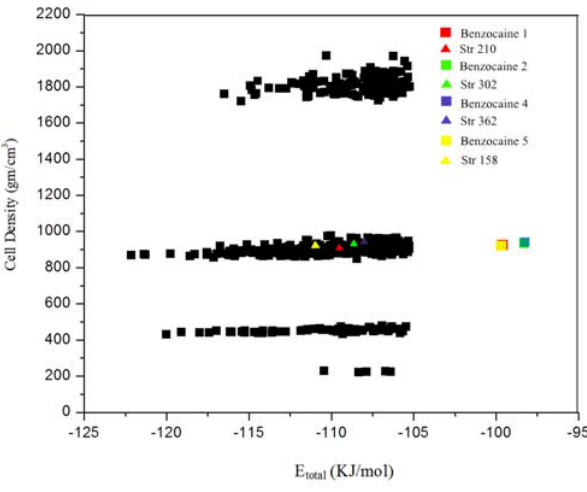
rated landscape. The COMPACK comparison of the